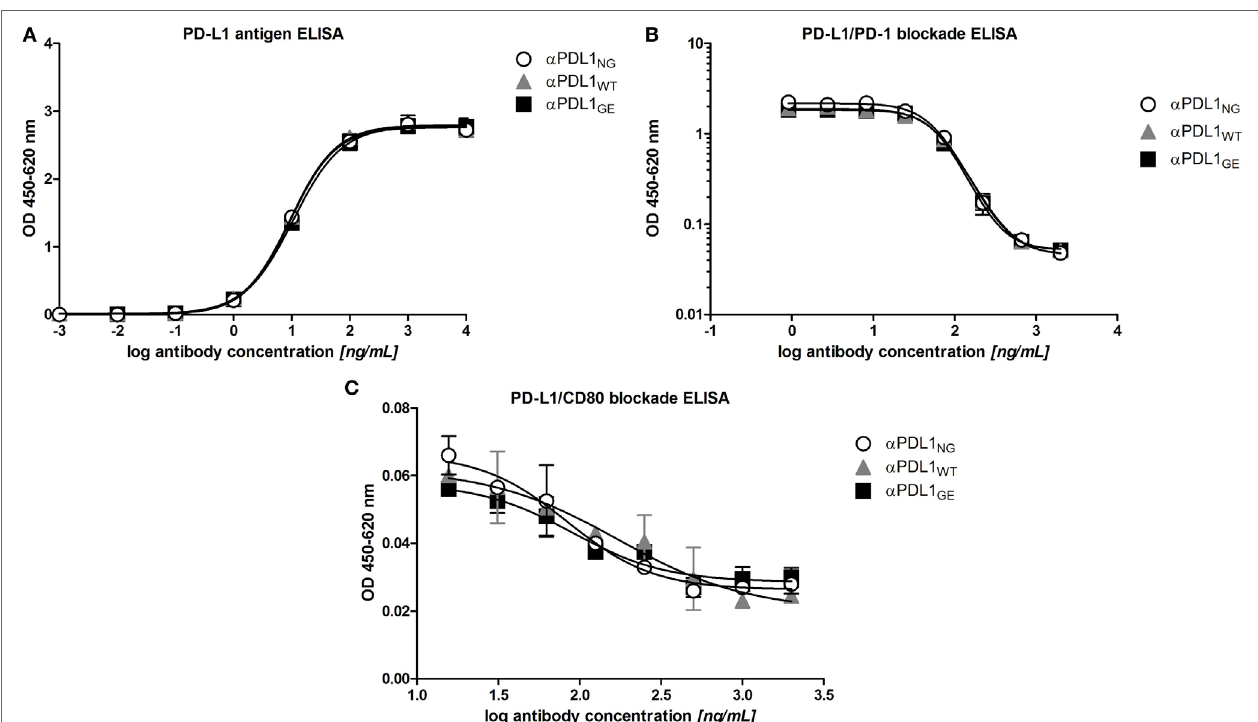
FigUre 2 | Glyco-engineered anti-human programmed death-ligand 1 (PD-L1) antibody and its normal and non-glycosylated counterparts show comparable antigen binding characteristics. The three anti-PD-L1 variants α PDL1 NG (open circles), α PDL1 WT (gray triangle), and α PDL1 GE (black squares) were tested for PD-L1 antigen binding and their capacity to block interaction with PD-L1 ligands in enzyme-linked immunosorbent assays (ELISA). (a) PD-L1 antigen binding ELISA. OD 450–620 values were plotted against increasing concentrations of test antibody to assess binding to plate-bound human PD-L1. (B) Competitive ELISA measuring binding of soluble programmed death 1 to plate-bound PD-L1 in presence of test antibody. OD4 450–620 values were plotted against increasing concentrations of test antibody. (c) Competitive ELISA measuring binding of soluble CD80 to plate-bound PD-L1 in presence of test antibody. OD 450–620 values were plotted against increasing concentrations of test antibody. Statistics: mean and SD were plotted in all graphs. Data are representative of two independent